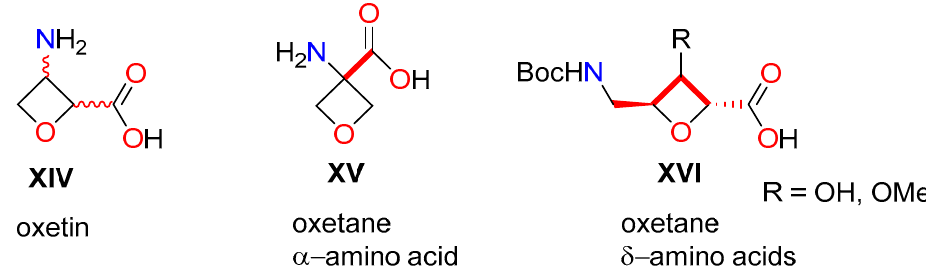
Figure 2. Oxetane amino acid compounds.